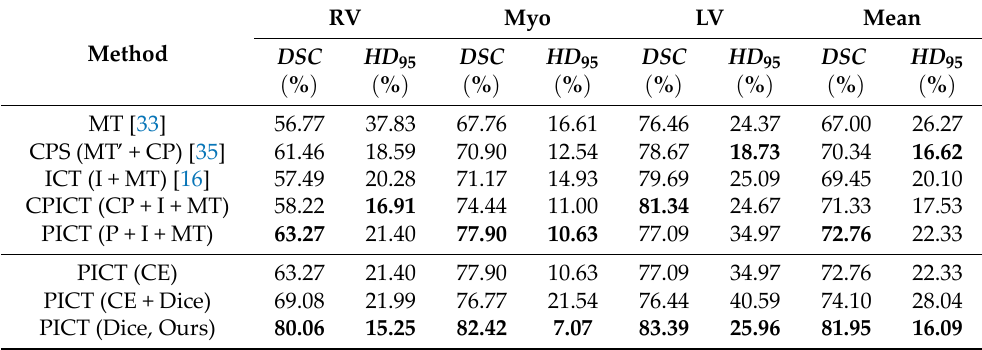
Table 2. Ablation analysis results on ACDC dataset using 3 labeled cases. The bold fonts indicate the best results of the comparing